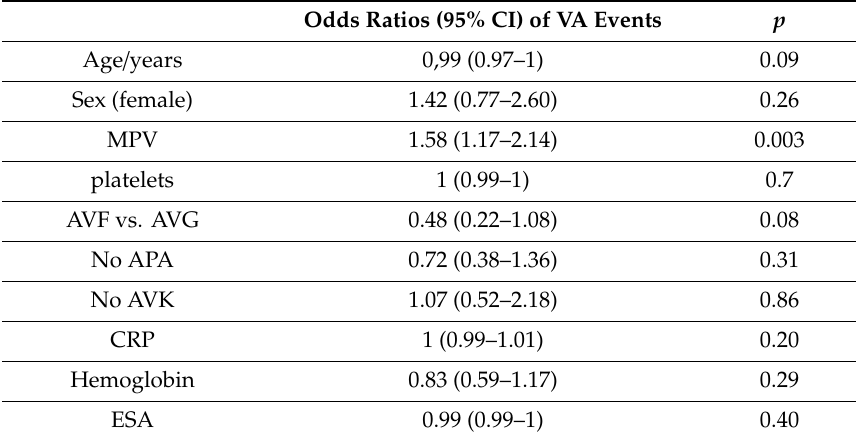
Table 3. Multivariate analysis by the Cox model of vascular access events.